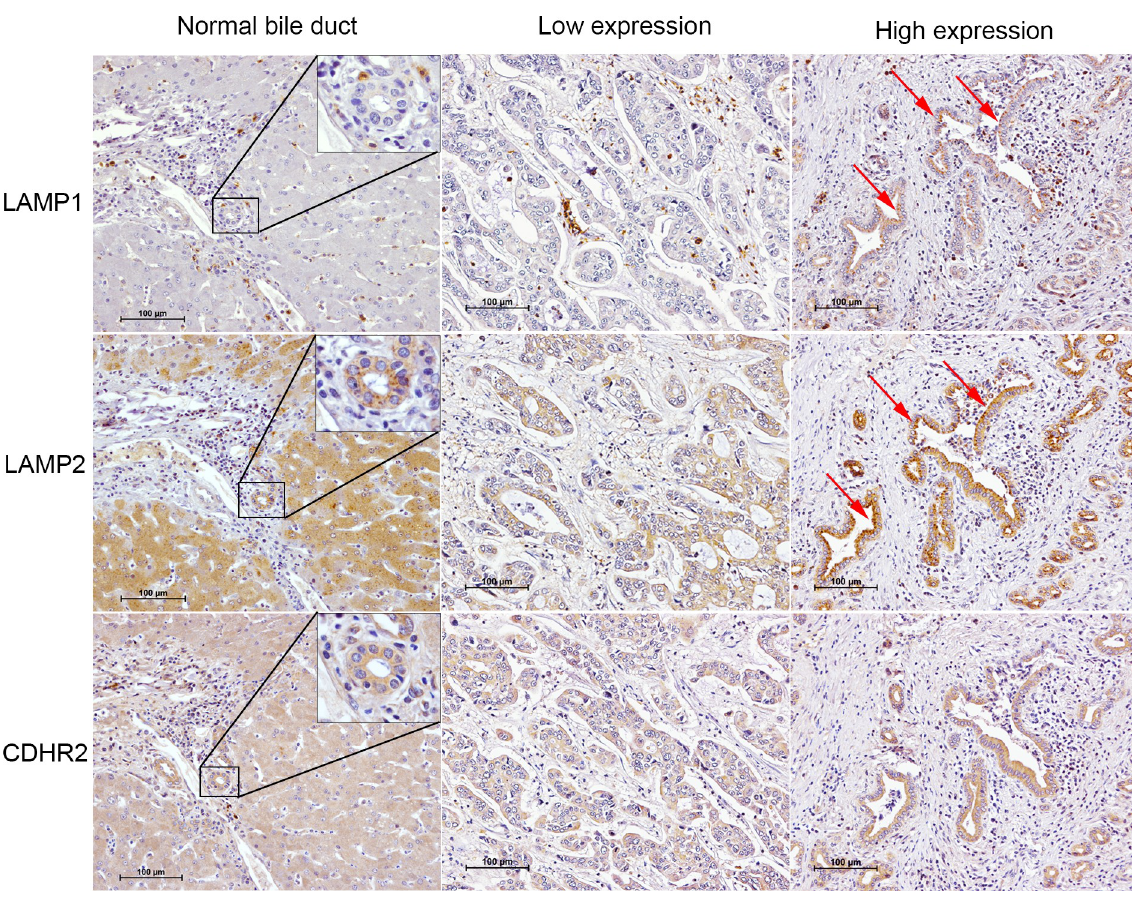
Fig 5. Immunohistochemical staining of three candidate proteins. LAMP1, LAMP2 and CDHR2, was performed on cadaveric donor liver tissues (the first column) and human CCA microtissue arrays which demonstrated low and high expression (the second and third column). The red arrows indicate the positive of LAMP1 and LAMP2 expression at the luminal surface (red arrows).